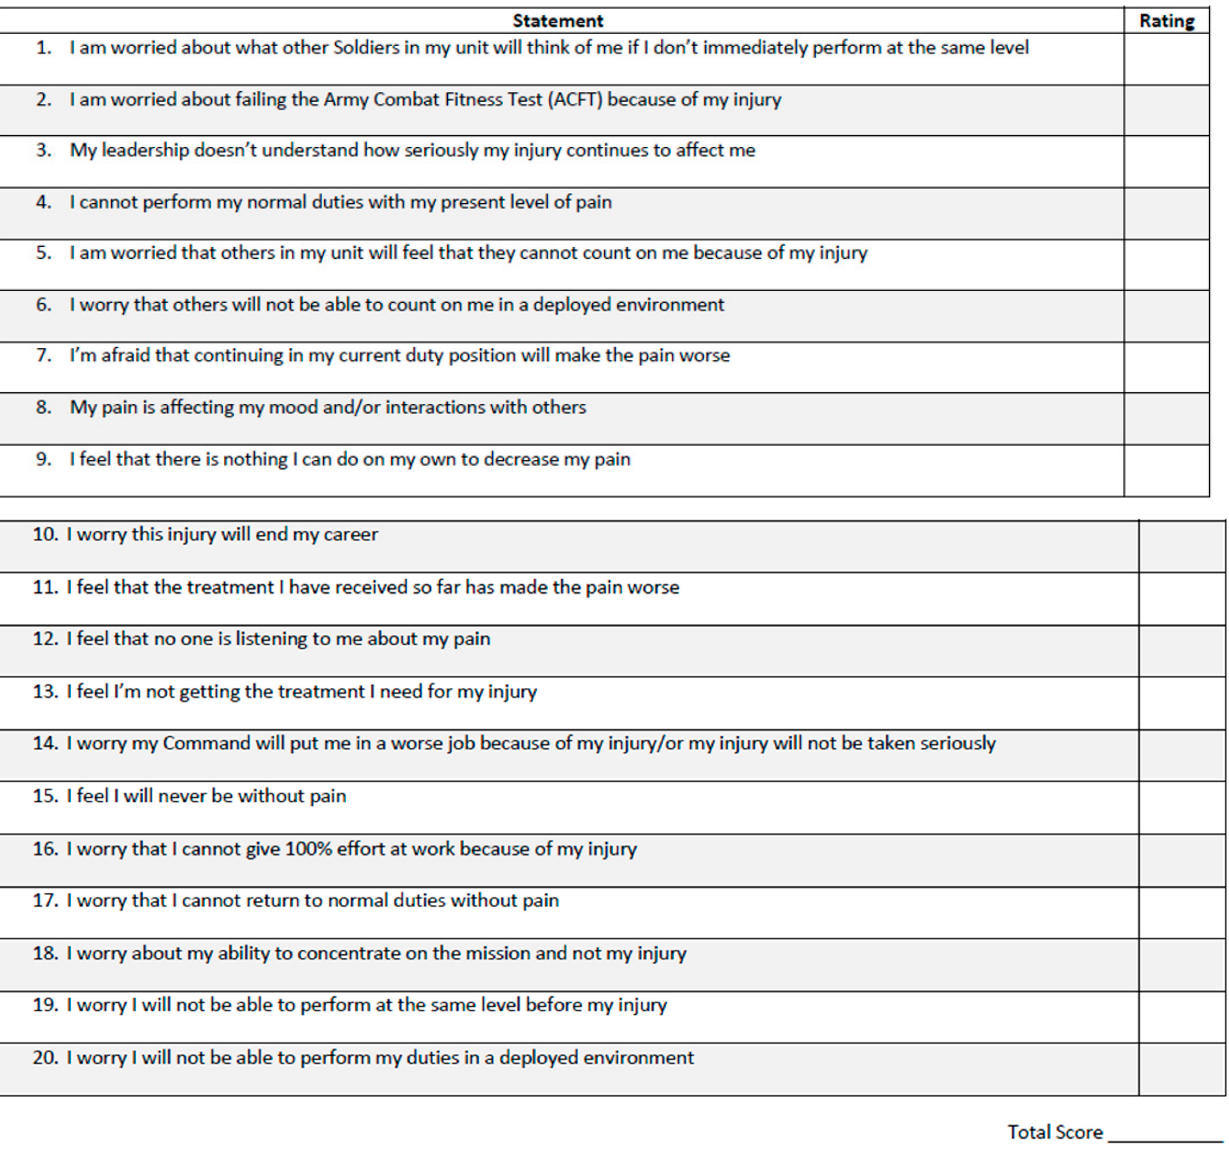
Figure A1. Return to Duty Readiness Questionnaire (RDRQ).